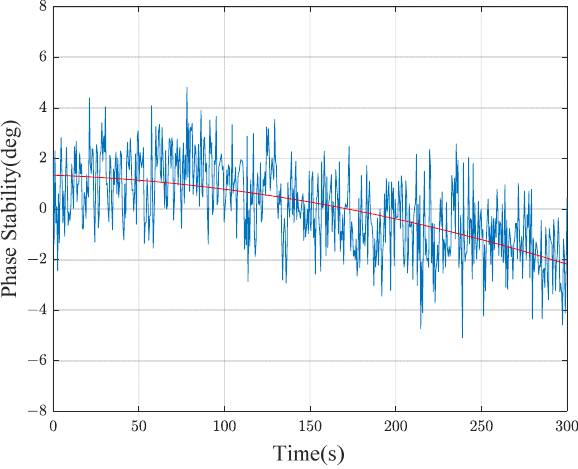
Figure 4. Simulation results of frequency and frequency error with time.